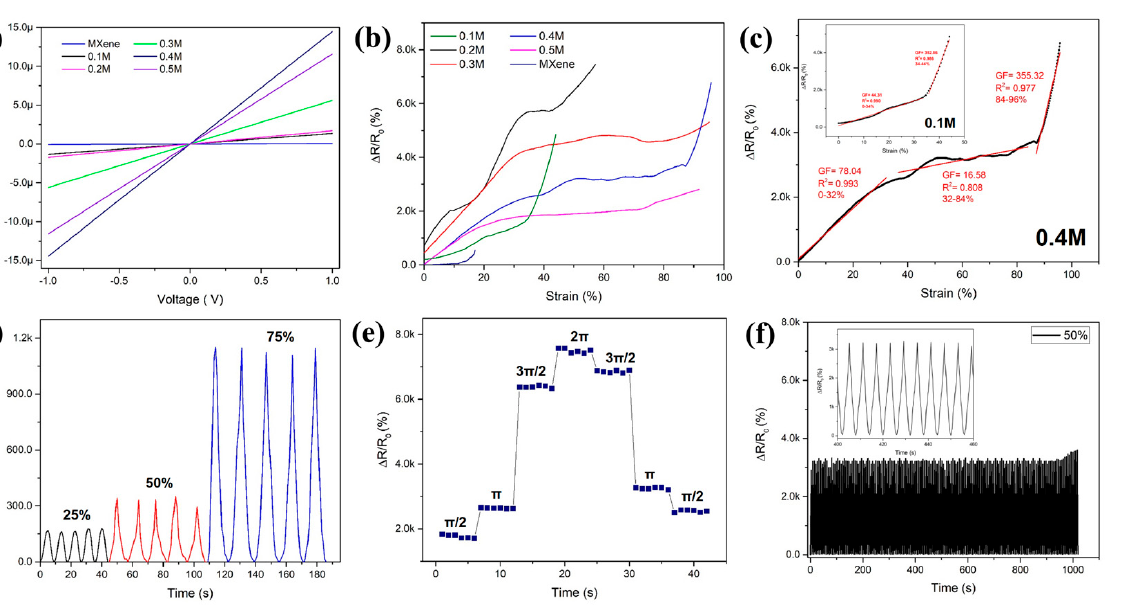
Figure 5. Electromechanical properties of the Ti 3 C 2 T x /PPy coated electrospun PVDF strain sensor. ( a ) Comparison of the variation of resistance change under quasi-static test for various FeCl 3 con- centrations used to fabricate the sensor. ( b ) The relative resistance changes of various concentration of FeCl 3 fabricated sensor. ( c ) The relative resistance changes of 0.4M FeCl 3 fabricated sensor ( d ) Relative resistance change of the sensor under stretch–release cycles at maximum strain of 25%, 50%, and 75%, respectively. ( e ) Torsion performance of the sensor with relative resistance changes under different torsion degrees. ( f ) Stability test under the strain of 50% for 1000 s.